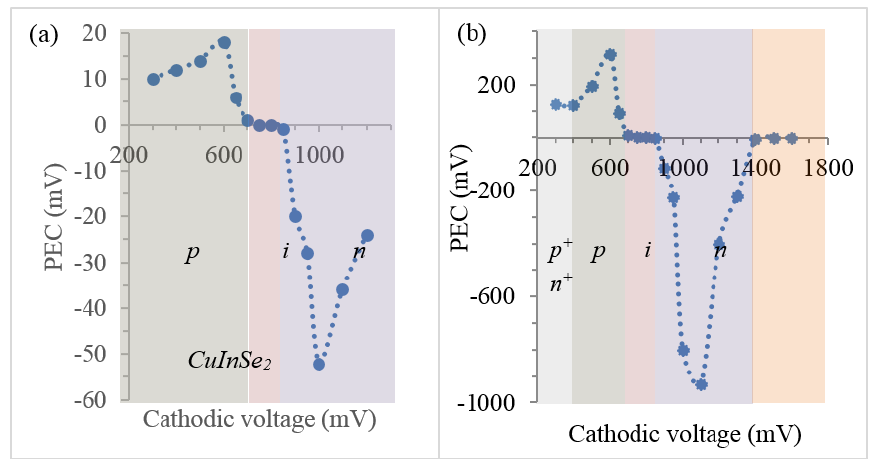
Figure 3. Photoelectrochemical (PEC) cell measurement signal for ( a ) CuInSe 2 and ( b ) CuInGaSe 2 with increasing cathodic voltages. Note the ability to grow p + , p, i, n, and n + materials from the same electrolyte, simply by varying the deposition voltage. Reproduced from [68,70] with permission; Copyright 2004 Sheffield Hallam University.